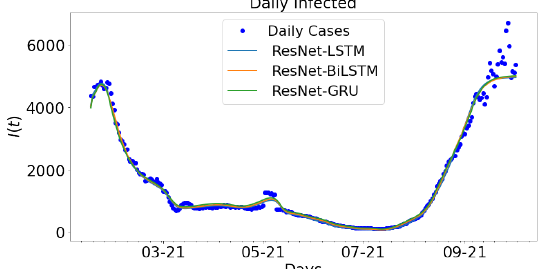
Figure 14. Data-driven simulation for ResNet-LSTM, ResNet-BiLSTM, and